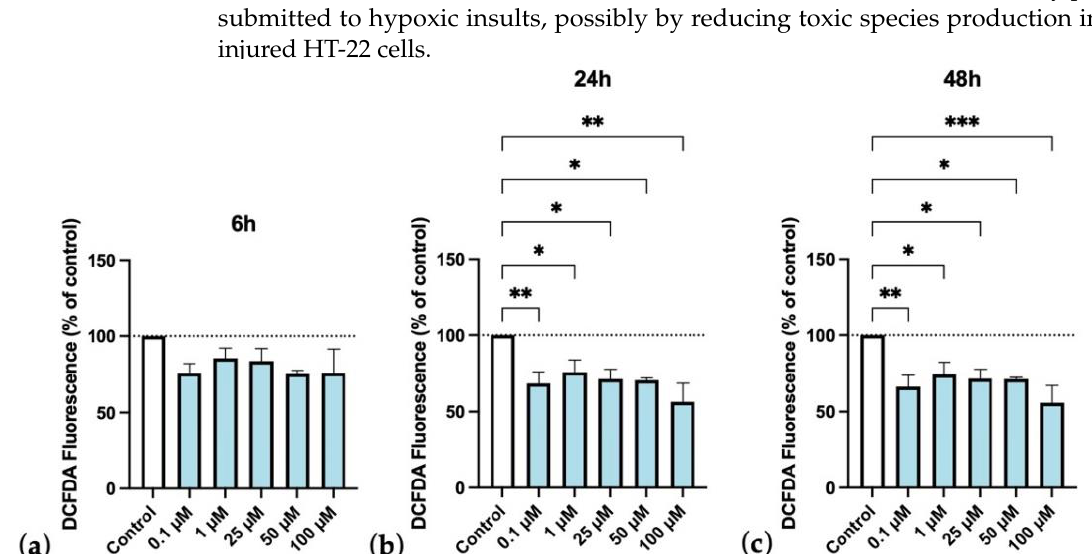
Figure 16. Protective efficacy of edaravone, perampanel, and metformin in HT-22 cells exposed to oxygen – glucose deprivation (OGD) over 6 ( A ), 24 ( B ), and 48 ( C ) hours. DCFDA fluorescence (dye of ROS generation) change percentage (%) of the different concentrations of edaravone, perampanel, and metformin, exposed to OGD. Results are expressed as the percentage of DCFDA fluorescence relative to control cells, in normal conditions. Results were assessed by fluorescence plate reader (SpectraMax Gemini EM Microplate Reader, Molecular Devices, San Jose, California), 485 nm exci- tation and 530 nm emission. Data are presented as the mean ± SEM of three independent experi- ments.